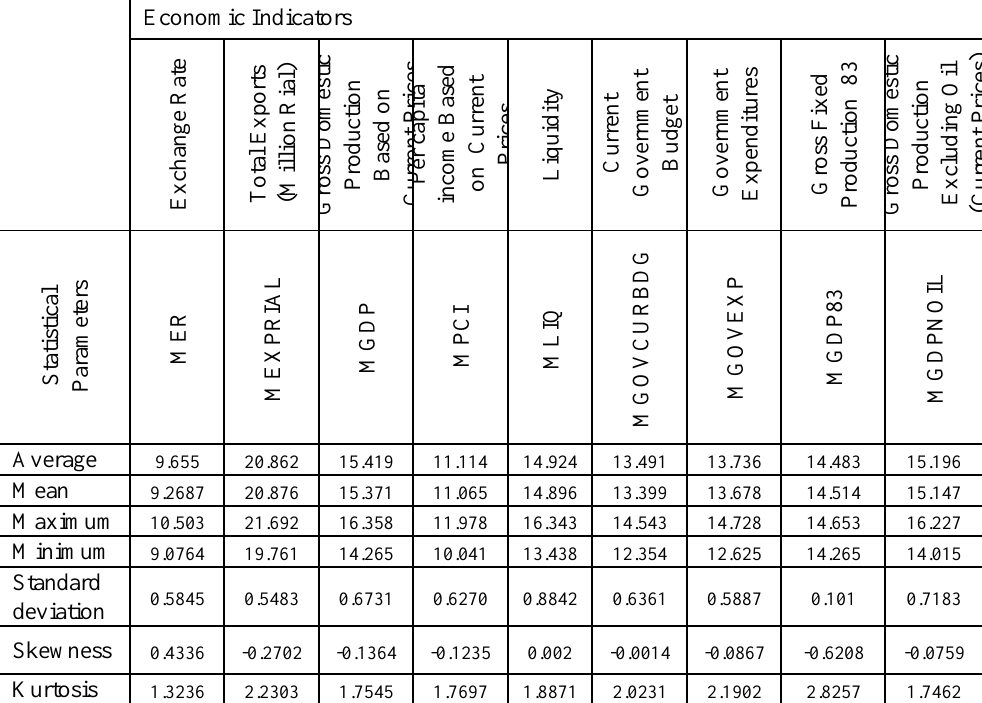
Table (3). Description of Variables Measuring the Economic Indicators of Sample Companies Studied during